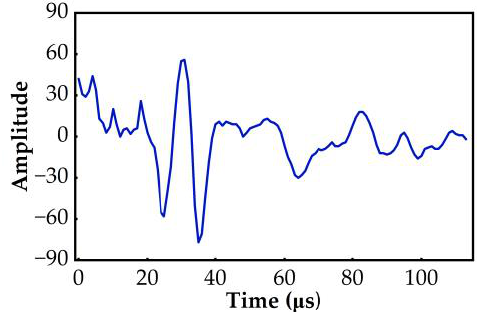
Figure 6. Abnormal signal in dataset 2.